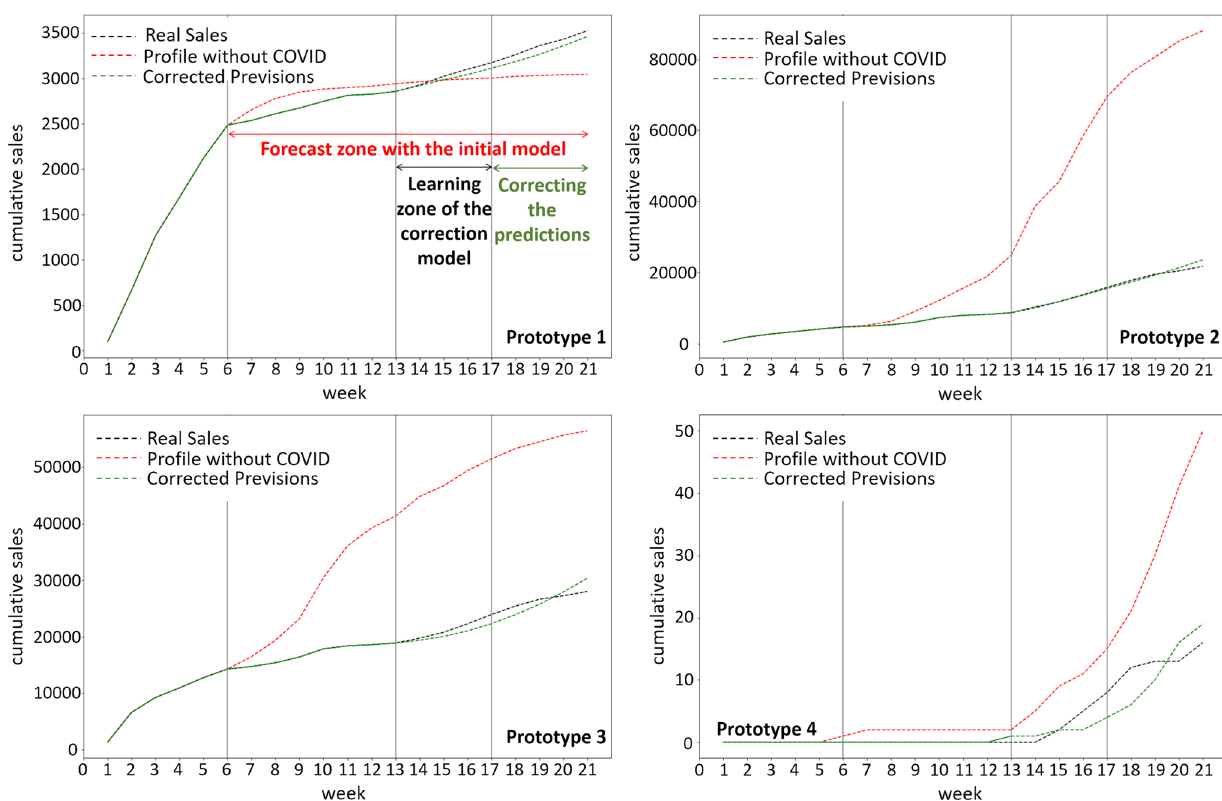
Fig. 12 The aggregation of cumulative sales of the blouses’ family, for the year 2020, without and with the impact of the sanitary crisis Table 6 Root mean squared errors between actual and predicted